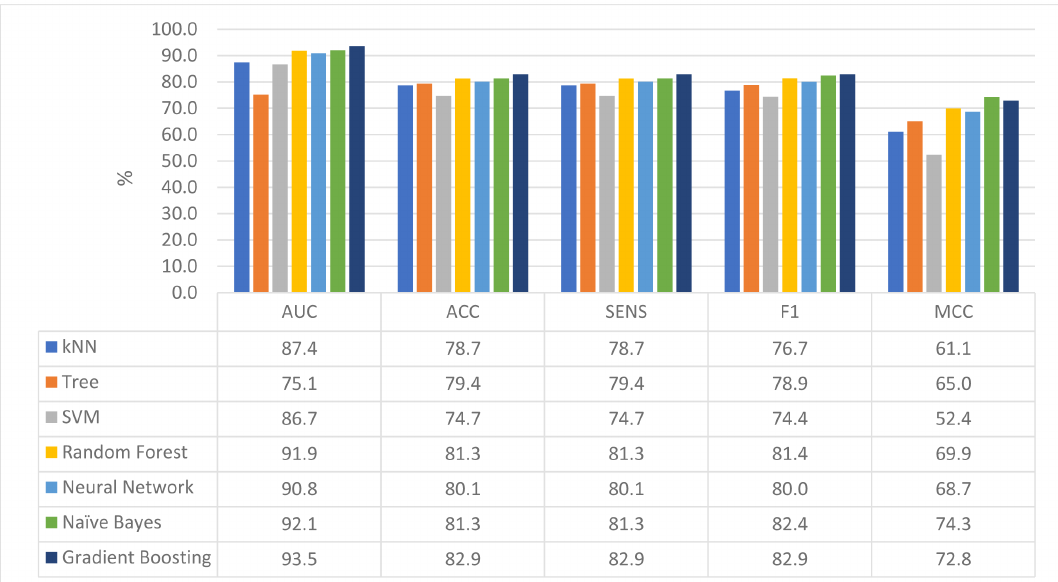
Figure 2. Evaluation of ML models performance analysis in predicting depression symptoms.